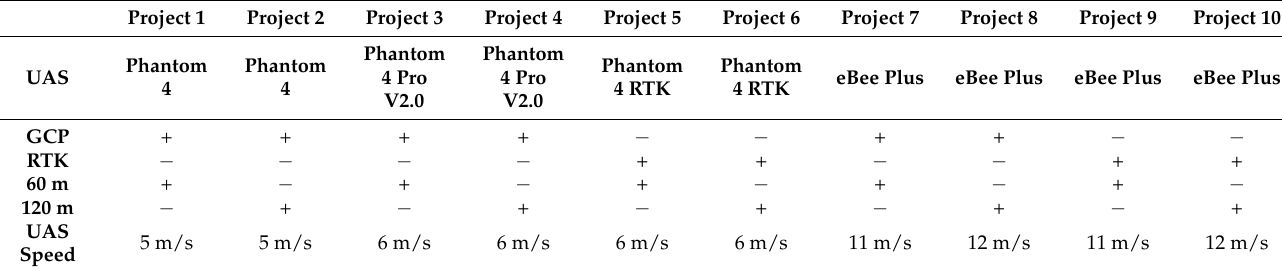
Table 1. Overview of the basic project